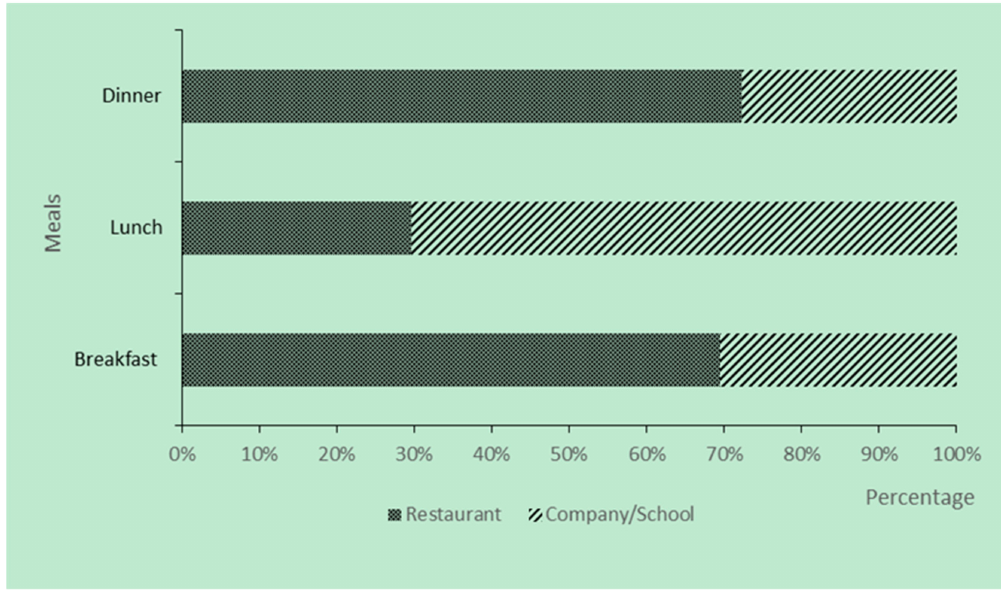
Figure 1. Location of eating